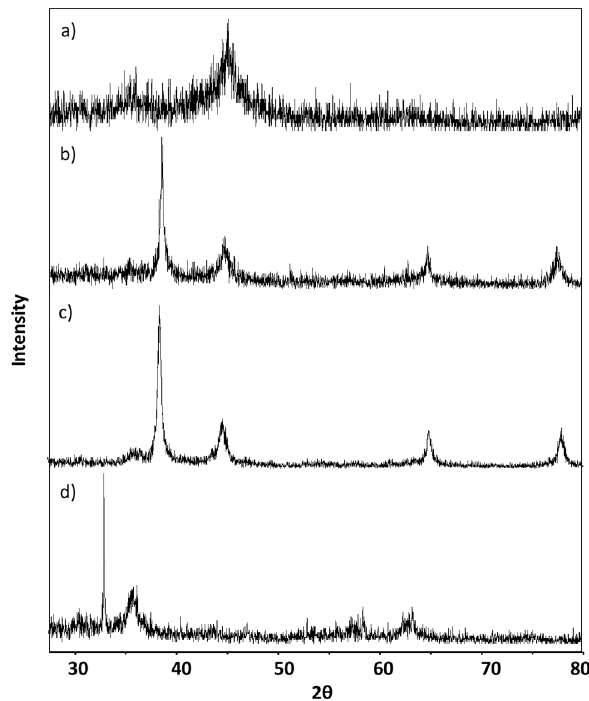
Figure 2. X-ray di ff raction (XRD) patterns of: ( a ) synthesized Fe, ( b ) Ag / Fe, ( c ) APTES–Ag / Fe, and Figure 2. X-ray diffraction (XRD) patterns of: ( a ) synthesized Fe, ( b ) Ag/Fe, ( c ) APTES–Ag/Fe , and ( d ) ( d ) PEI–Ag / PEI–Ag/Fe.